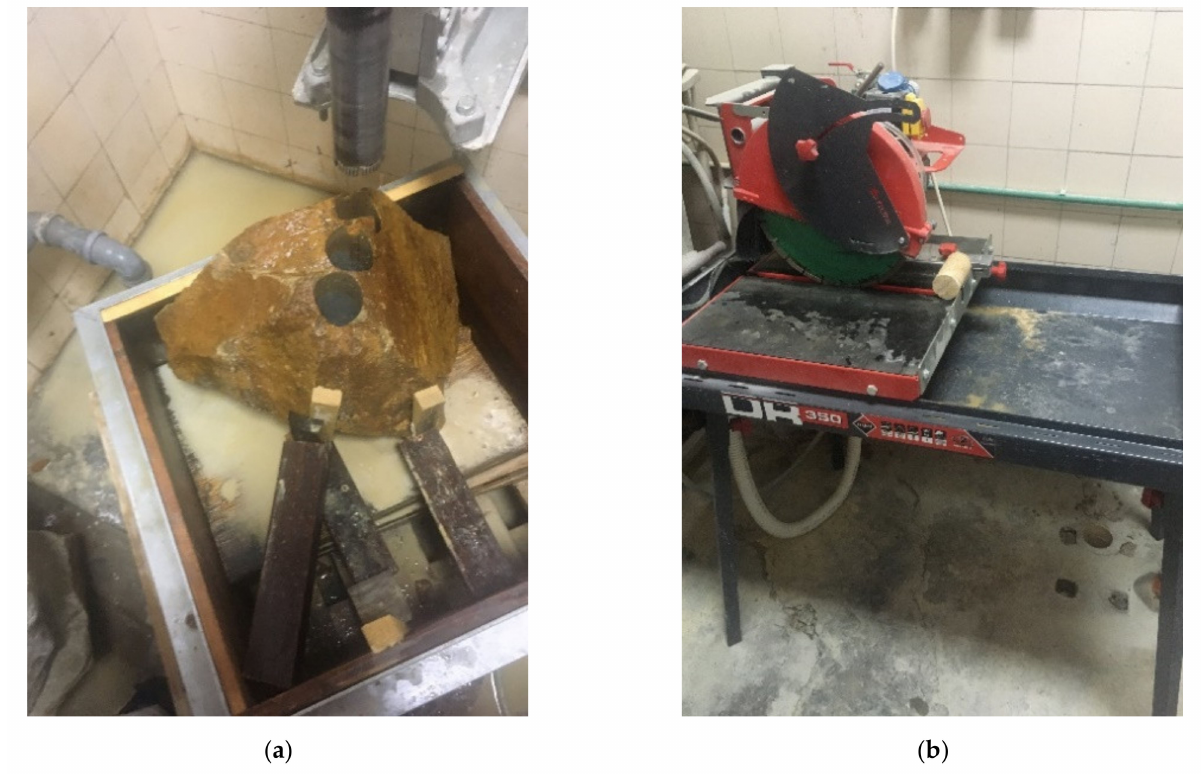
Figure 3. Procedure for preparation of specimen for laboratory tests: ( a ) drilling process, ( b ) cutting process.